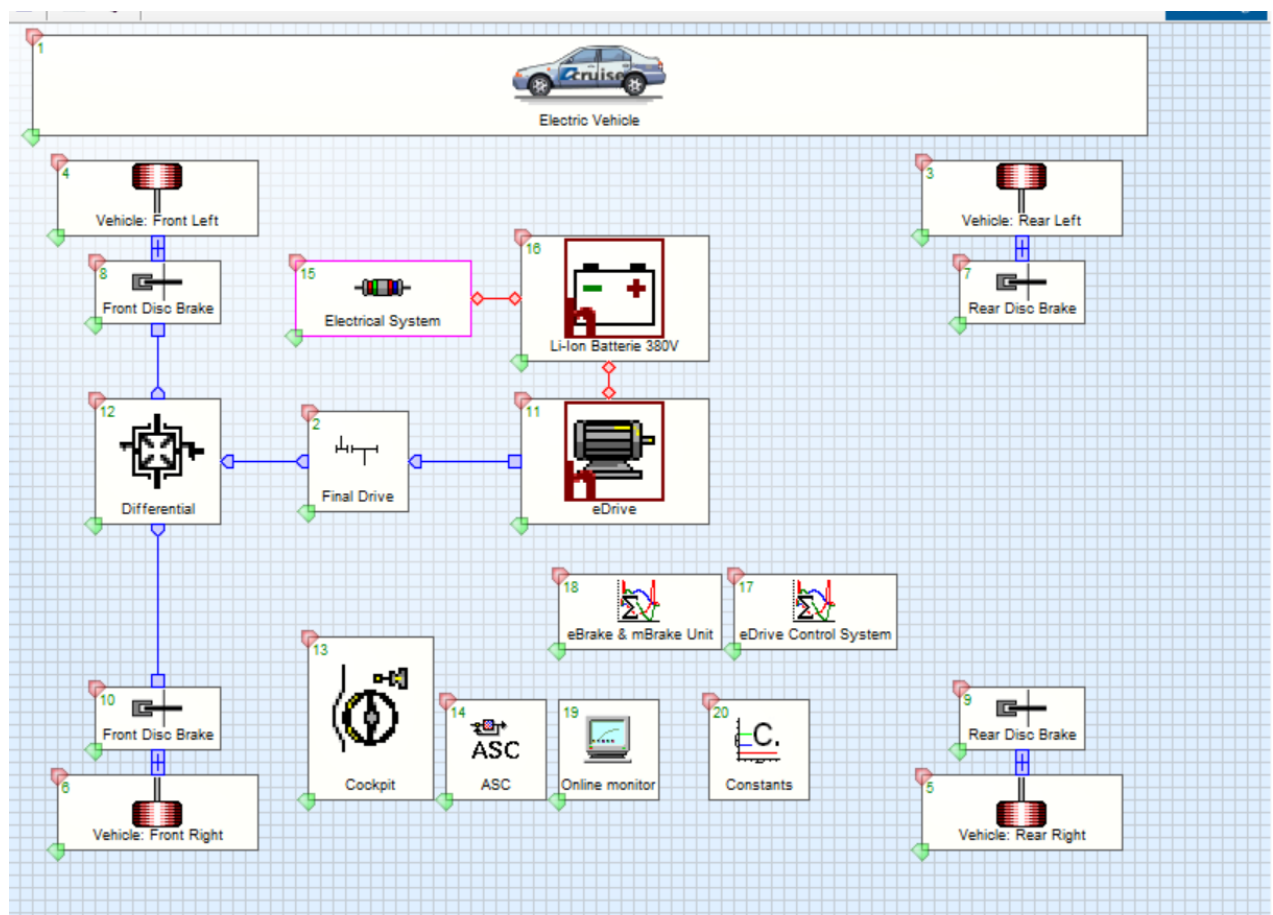
Figure 4. Cruise-based energy consumption model for the test vehicle. After the initial model was established, it was verified and validated with laboratory data. Firstly, the EU300 model in Cruise was run under the virtual NEDC standard at 25 ◦ C room temperature, and as the result, the energy consumption of the model was obtained. Then the actual vehicle was used to do the drum test in the laboratory at the same temperature and under the same working condition, as shown in Figure 5, and the measured data of the electric system and the actual energy consumption were read. The model was calibrated and optimized with the measured data in the experiment so as to ensure the credibility of the basic